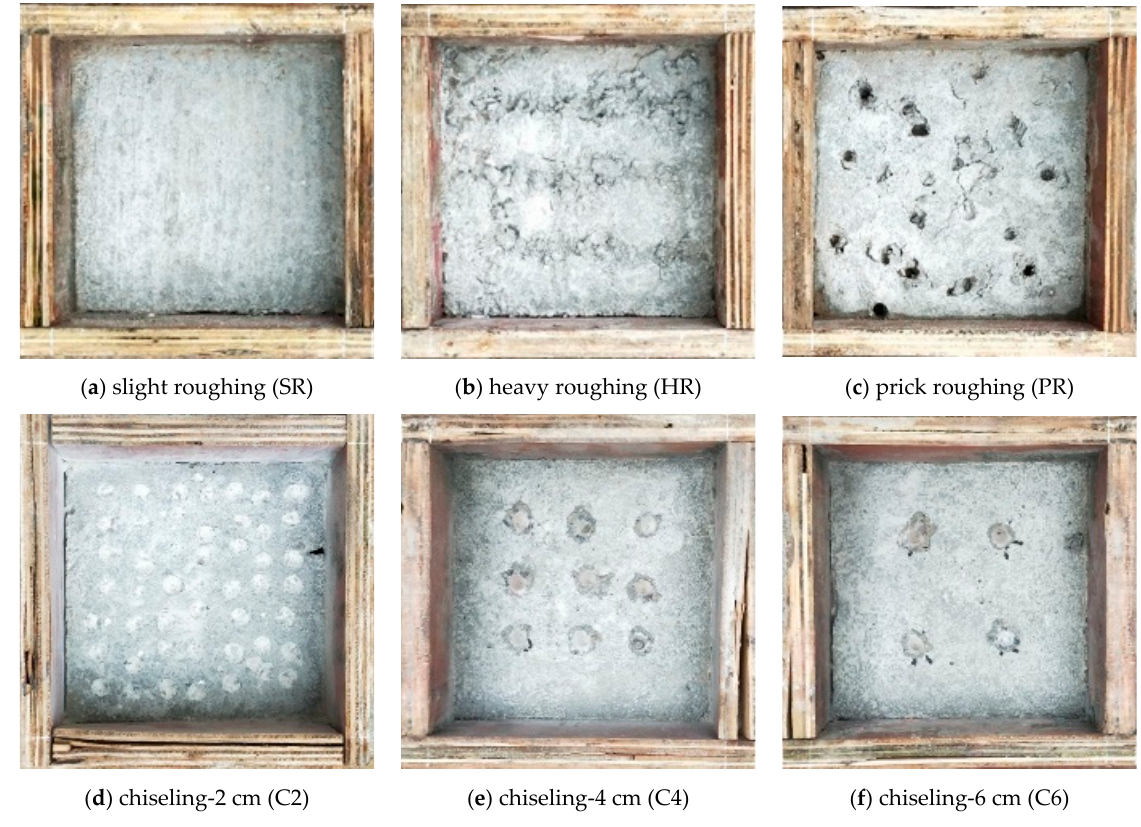
Figure 1. Interface